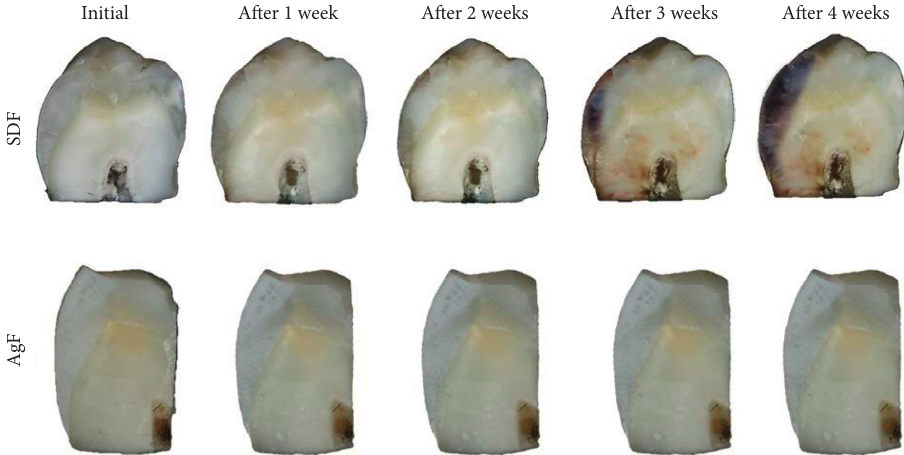
Figure 7: Photographic image of cross-sectional enamel demineralized specimens treated with SDF and AgF, 4-week